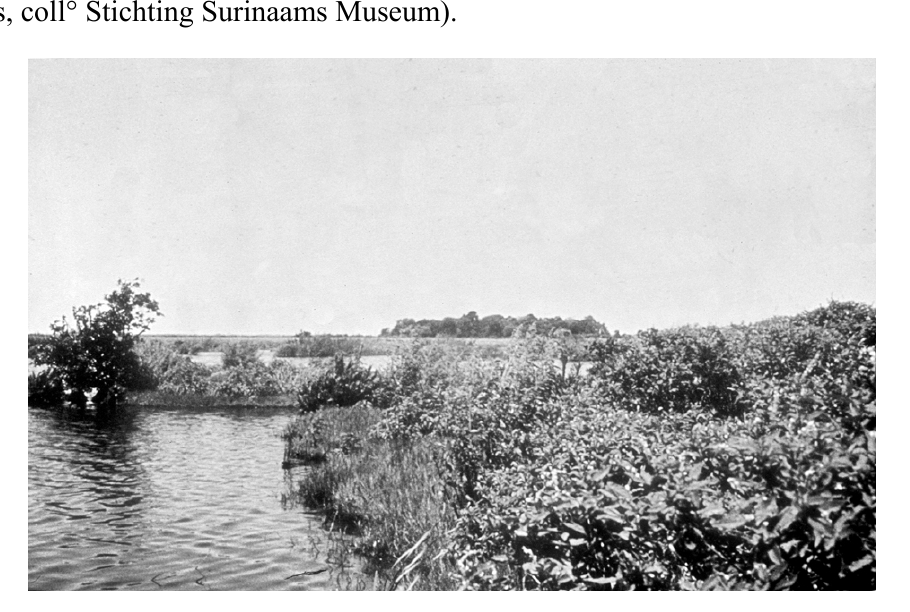
Figure 11. Hertenrits mound view from the raised fields, western Suriname coast (photo Geijskes, coll° Stichting Surinaams